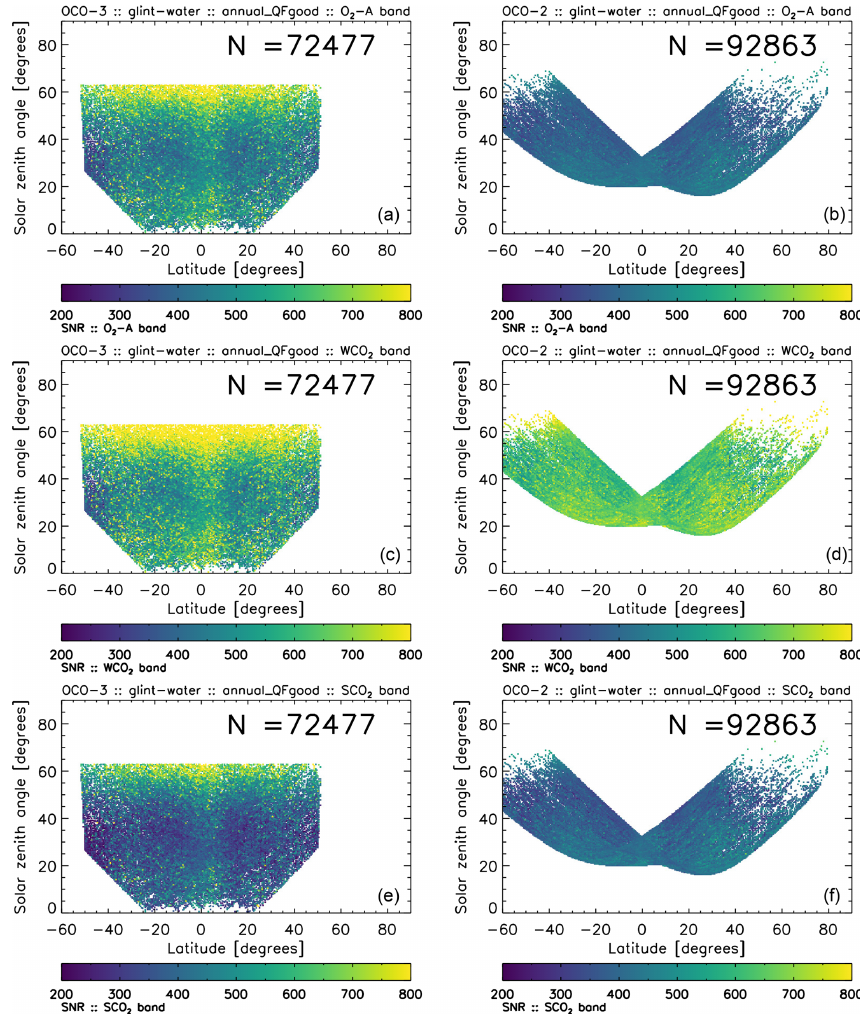
Figure 11. Same as Fig. 10, but for glint–water soundings.